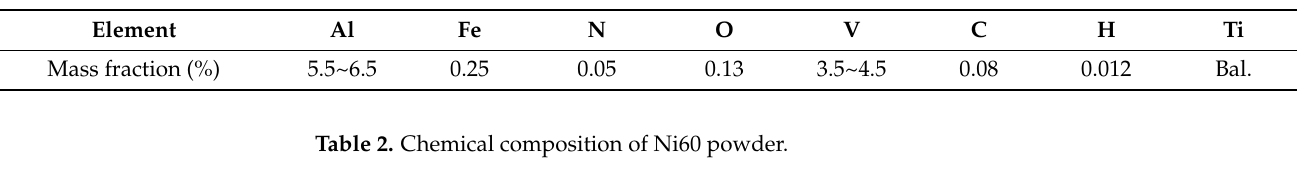
Figure 1. Schematic diagram of laser cladding.